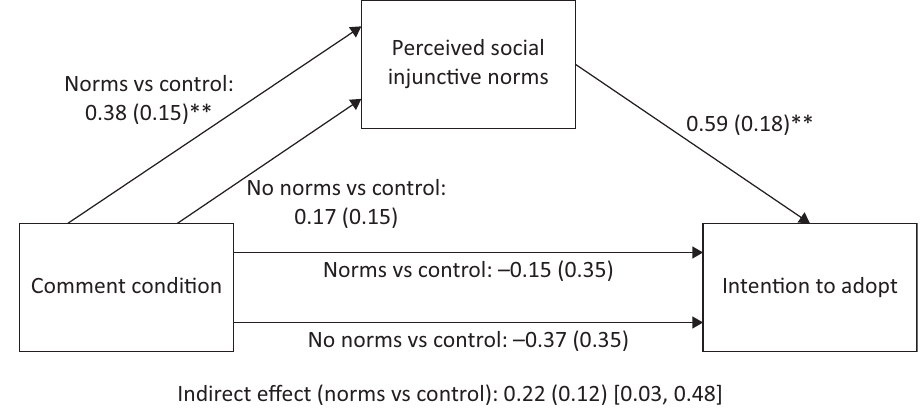
Figure 2. Mediated effect of comments on intention to adopt through perceived injunctive norms. Notes: * p ≤ 0.05, ** p ≤ 0.01. Coefficients associated with each path presented as b (SE). Model statistics: Step 1— F (2,160) = 3.38, p = 0.04, adj. R 2 = 0.03; Step 2— F (3,159) = 3.24, p = 0.02, adj. R 2 =